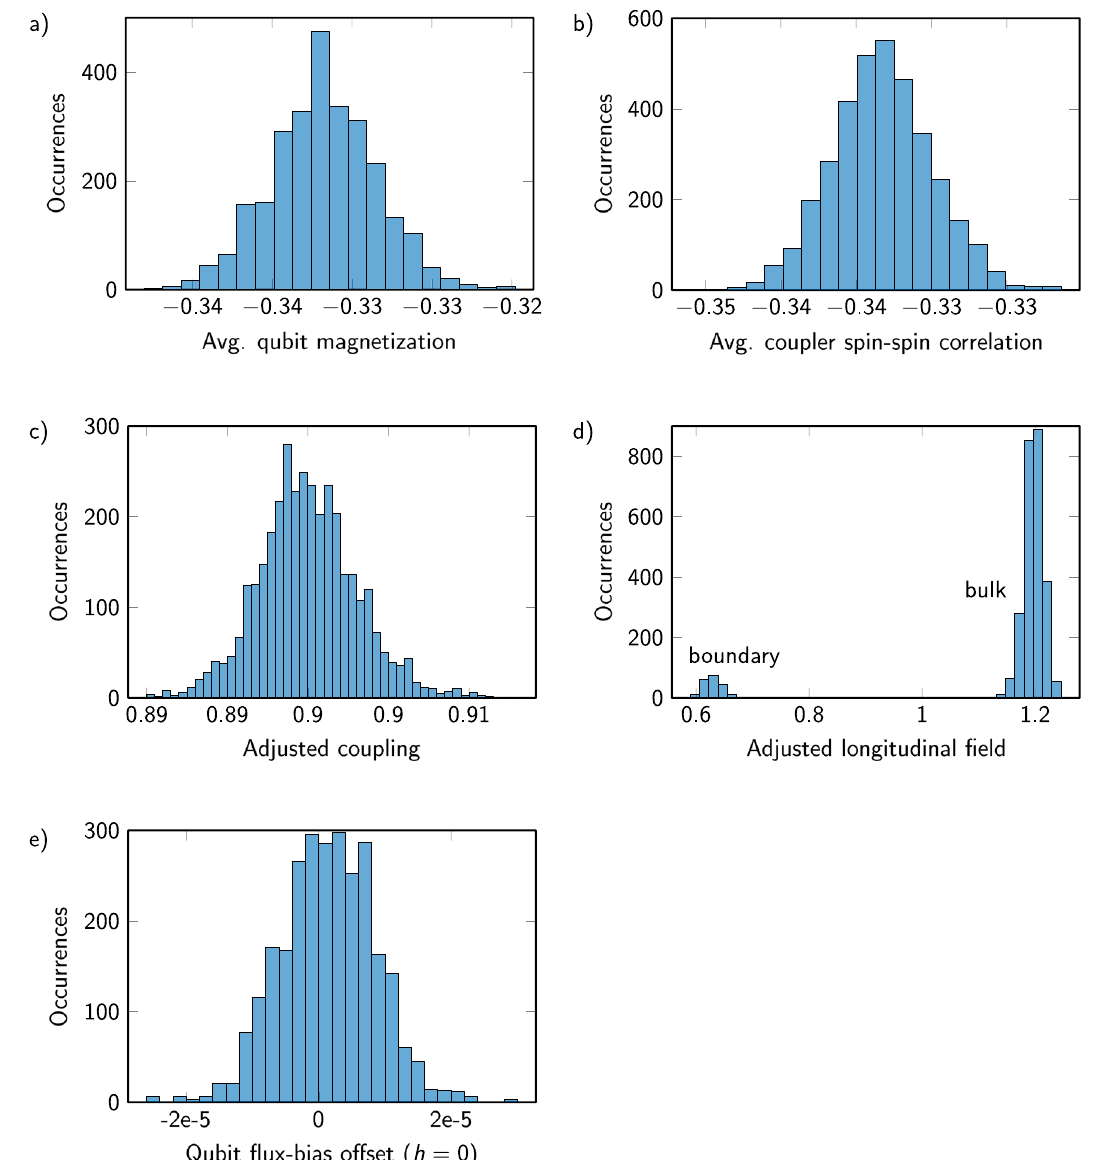
fi elds ( d ),and qubits are balanced using fl ux-bias offsets at h =0 thatare also used atnonzero h .Notethetwomodesin d ,whereboundaryspinsareassignedroughly half the fi eldof bulkspins,inaccordance withtheirdegreeinthegraph, to achieve similar